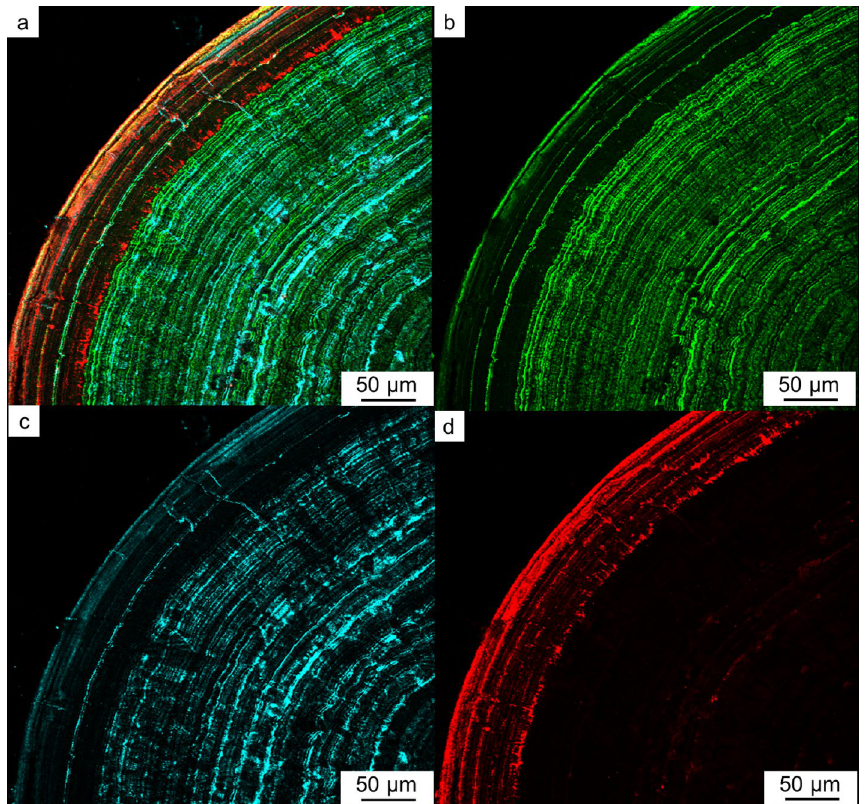
Figure 5. Protein distributions in a conically laminated COM. ( a ) Multi-IF image. ( b ) IF image of OPN. ( c ) IF image of RPTF-1. ( d ) IF image of